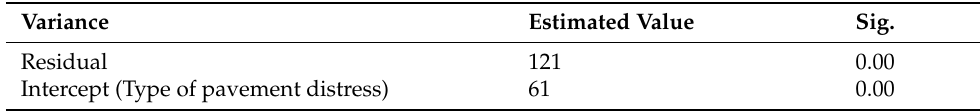
Table 4. Variance values of the random effect